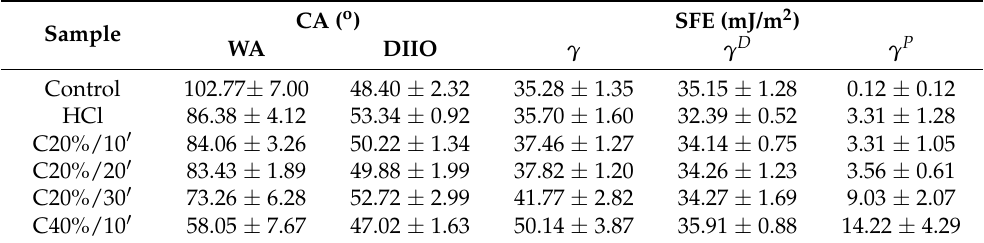
Table 3. Values (mean ± standard deviation) of contact angle of water (WA) and diiodomethane (DIIO), and the estimated surface energy (SFE) with their polar ( γ P ) and dispersive ( γ D ) components, for each surface treatment.